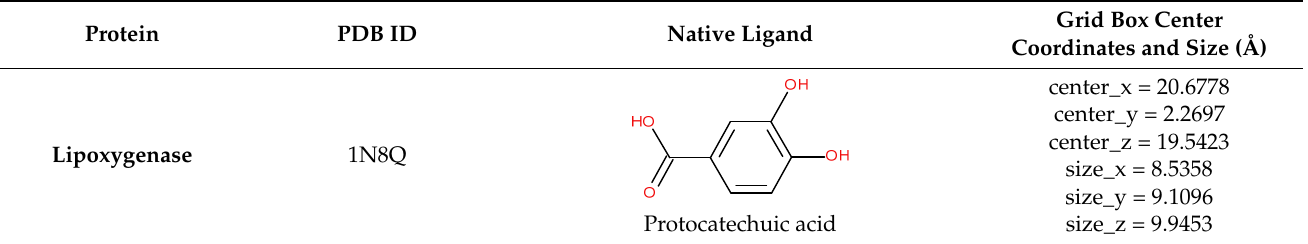
Grid Box Center Coordinates and Size (Å)